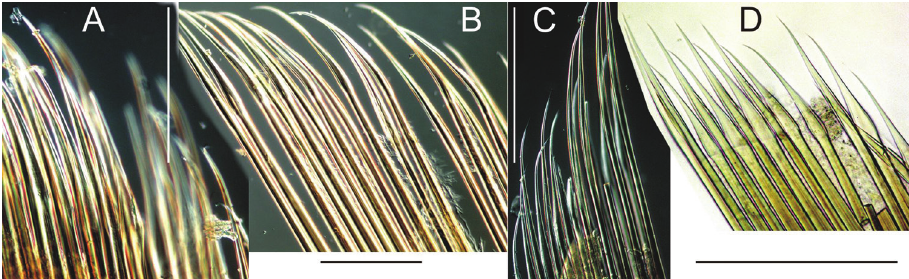
Figure 11. Notochaetae of Thelepus. A T. davehalli B T. cincinnatus C T. marthae D T. parapari . Scale bars: 0.25 mm. A Sevastopol 15.2587 C7 B Alaid 30.6 C4 C Tunetz 105.6 C9 D MNCN 5706